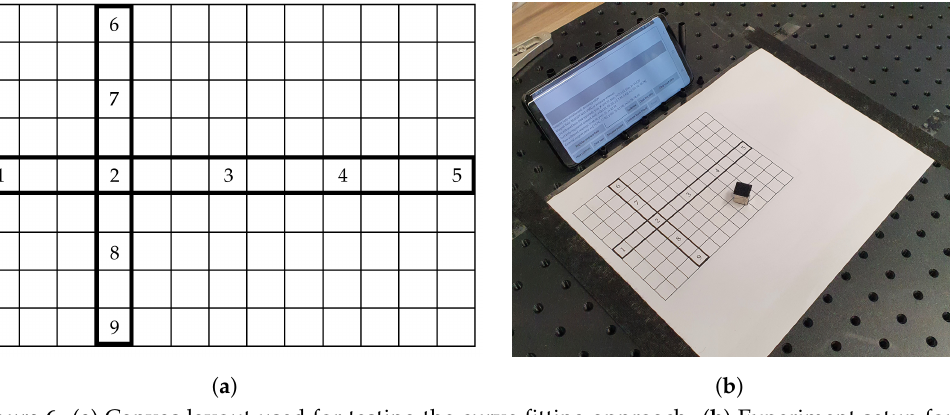
Figure 6. ( a ) Canvas layout used for testing the curve fitting approach. ( b ) Experiment setup for testing the curve fitting approach.